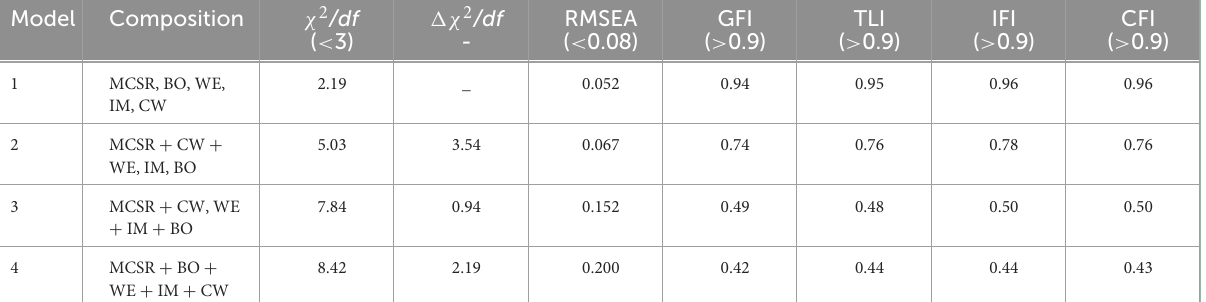
TABLE 4 Model fitness.